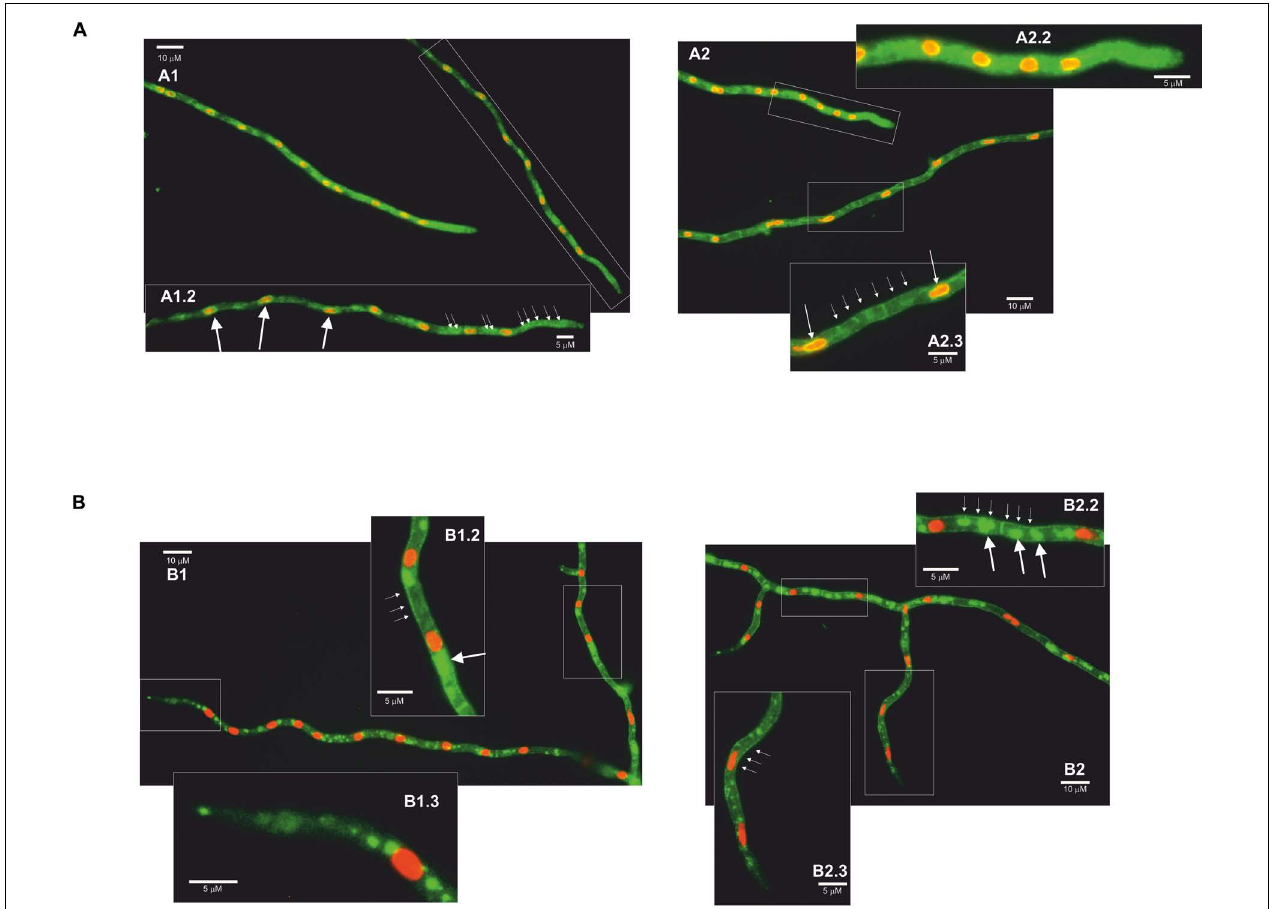
FIGURE 6 | Fluorescence microscopy images of AnCtrC and AnCtrA chimeras. (A) AnCtrC:GFP-Hhoa:mRFP protein expressing strains were grown in selective WATCH medium for 16 h at 30 ◦ C. Images show the protein localization before BCS addition (A1) and 2 h after 100 µ M BCS addition (A2) . Pictures A1.2–A2.2–A2.3 show a closer look at the most interesting features. (B) AnCtrA:GFP-HhoA:mRFP protein expressing strains were grown in selective WATCH medium for 16 h at 30 ◦ C. Images show the protein localization before BCS addition (B1) and 2 h after 100 µ M BCS addition (B2) . Pictures B1.2–B1.3–B2.2–B2.3 show a closer look at the most interesting